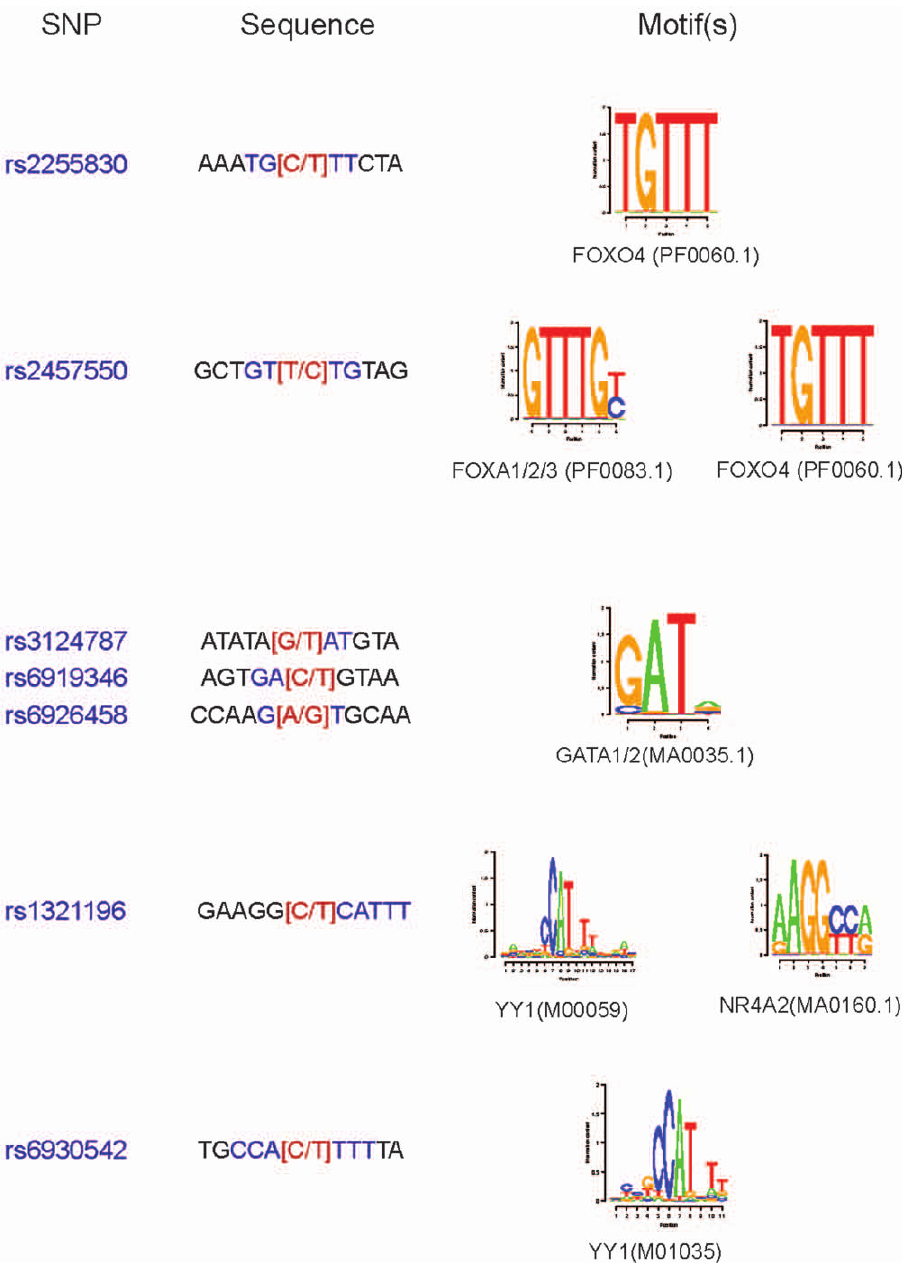
Figure 5. Mapping of Lp(a) associated SNP regions to transcription factor binding motifs. Sequences surrounding each of the 24 Lp(a) significantly associated SNPs were scanned for transcription factor binding motifs from the Transfac and Jaspar databases. Sequence logos for binding motifs predicted to be disrupted by allelic variation are displayed along with the HGNC symbol of associated transcription factor and the Jaspar or Transfac motif ID. Only transcription factors with literature evidence of liver expression are